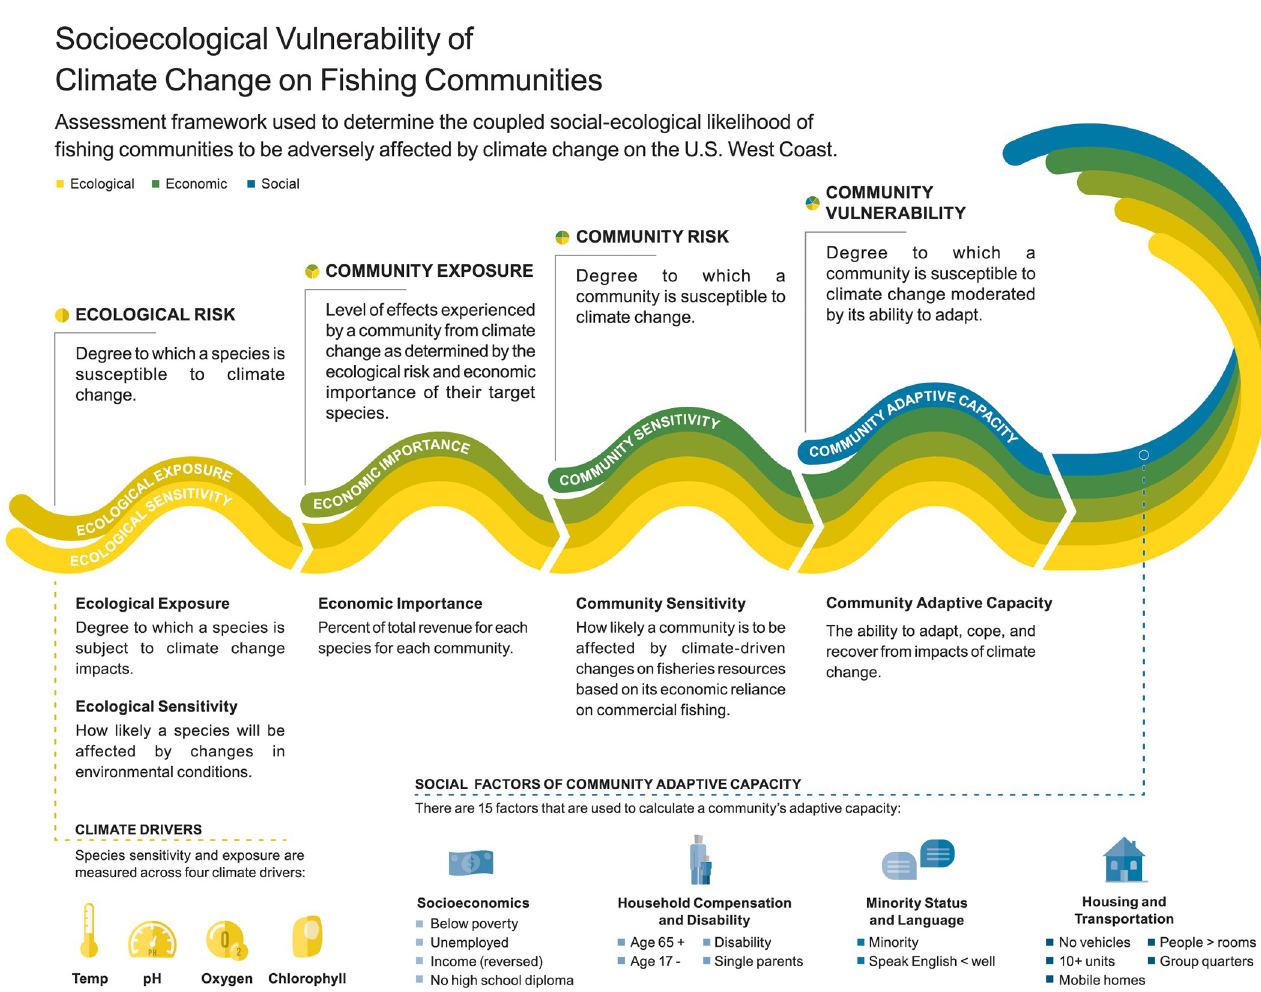
Fig 1. Vulnerability assessment framework. Framework used to determine the coupled social-ecological vulnerability of fishing communities to climate change on the U.S. West Coast. The initial components of the framework are the ecological sensitivity and exposure to climate change of marine resources that fishing communities depend on. Ecological sensitivity and exposure are determined for four climate change variables–temperature, pH, oxygen, and chlorophyll–and are combined to determine ecological risk. Community exposure is derived by weighting ecological risk of species by the economic importance to each community. When community exposure is combined with community sensitivity, this forms community risk to climate change. When community risk is combined with adaptive capacity, which is made up of 15 social indicators, this produces overall community vulnerability which is made up of ecological (yellow), economic (green), and social indicators (blue). Design by SJ